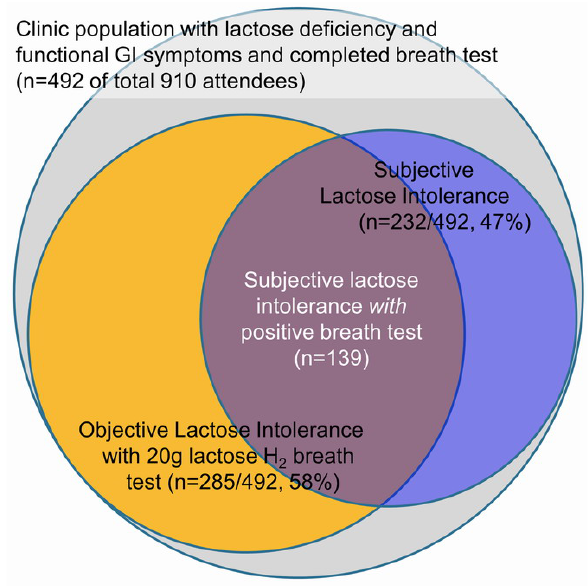
Figure 5. Lack of agreement between objective and subjective assessment of lactose intolerance